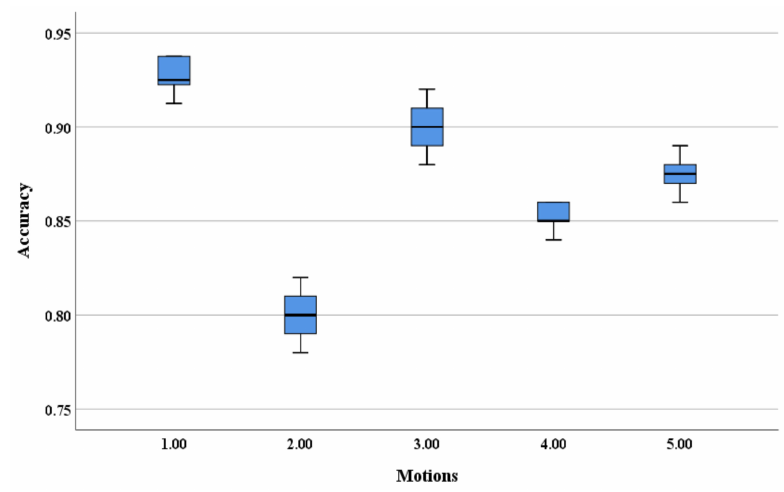
Figure 13. Accuracy for each motion